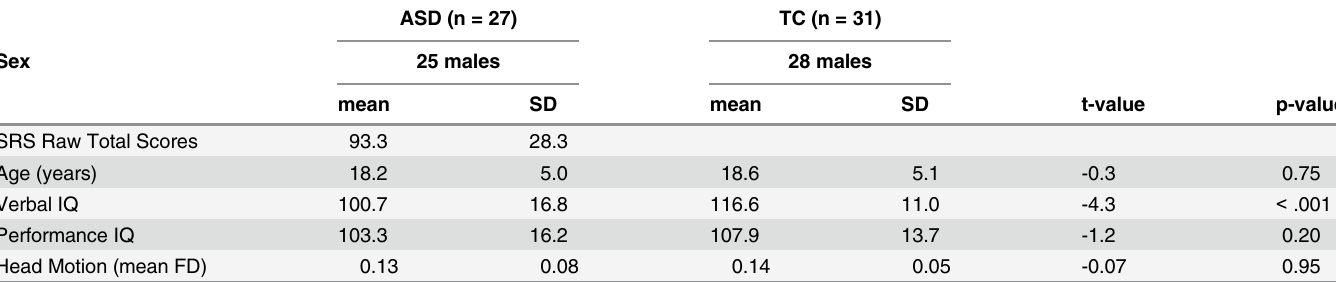
Table 1. Group characteristics for the ASD and TC participants (adolescents and adults